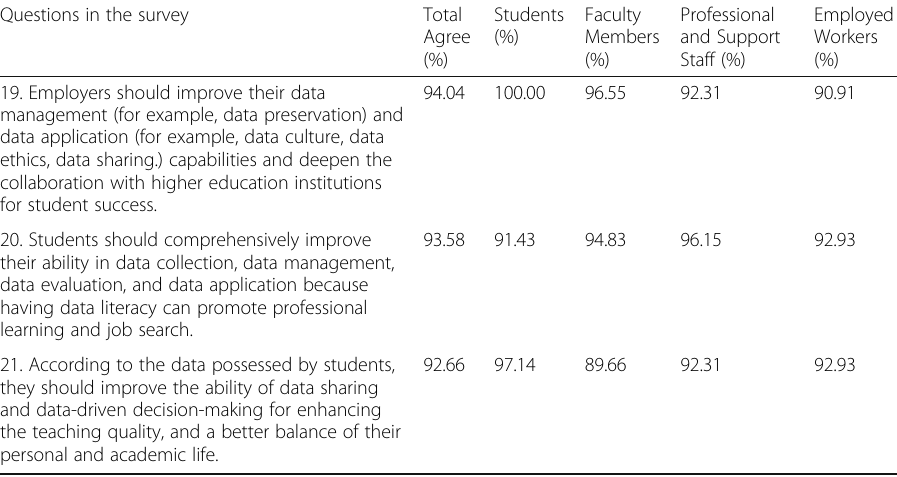
Table 3 A Brief Summary of the Survey Result (Continued) Questions in the survey Total